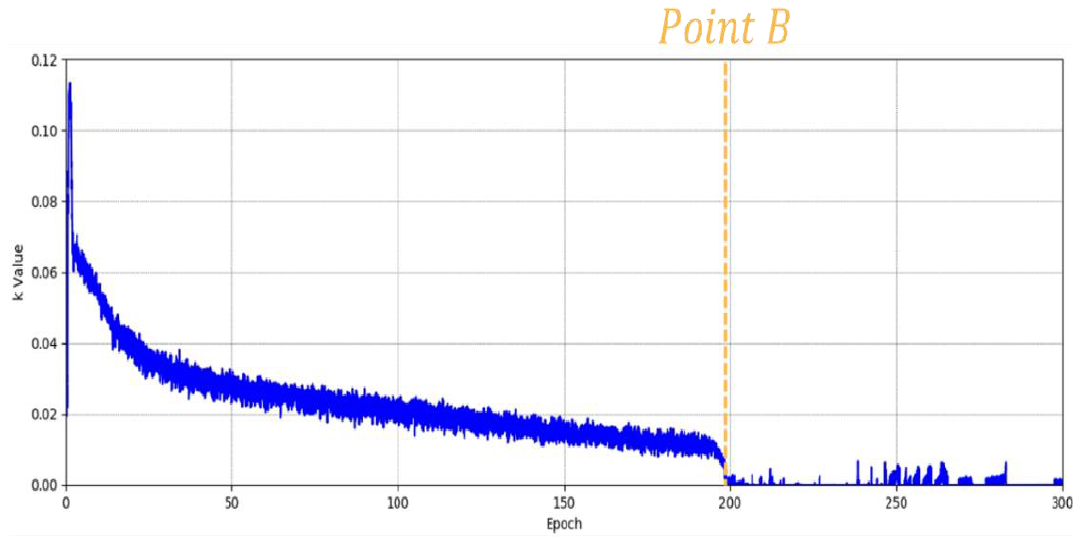
Figure 16. Results of convergence measurement for the BEGAN-CS (Boundary Equilibrium Generative Adversarial Network with Constrained Space) model.